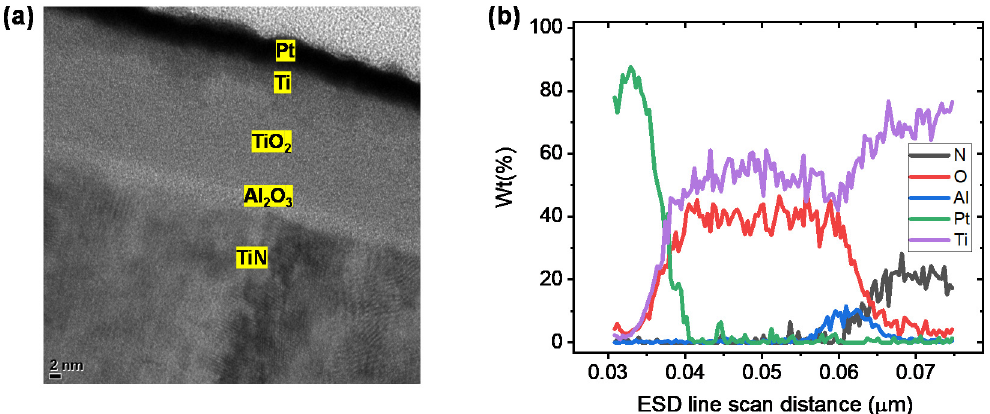
Figure 1. ( a ) High resolution transmission electron microscopy (TEM) image and ( b ) Energy-dispersive spectroscopy (EDS) line scan of a Pt/Ti/TiO 2 /Al 2 O 3 /TiN device.